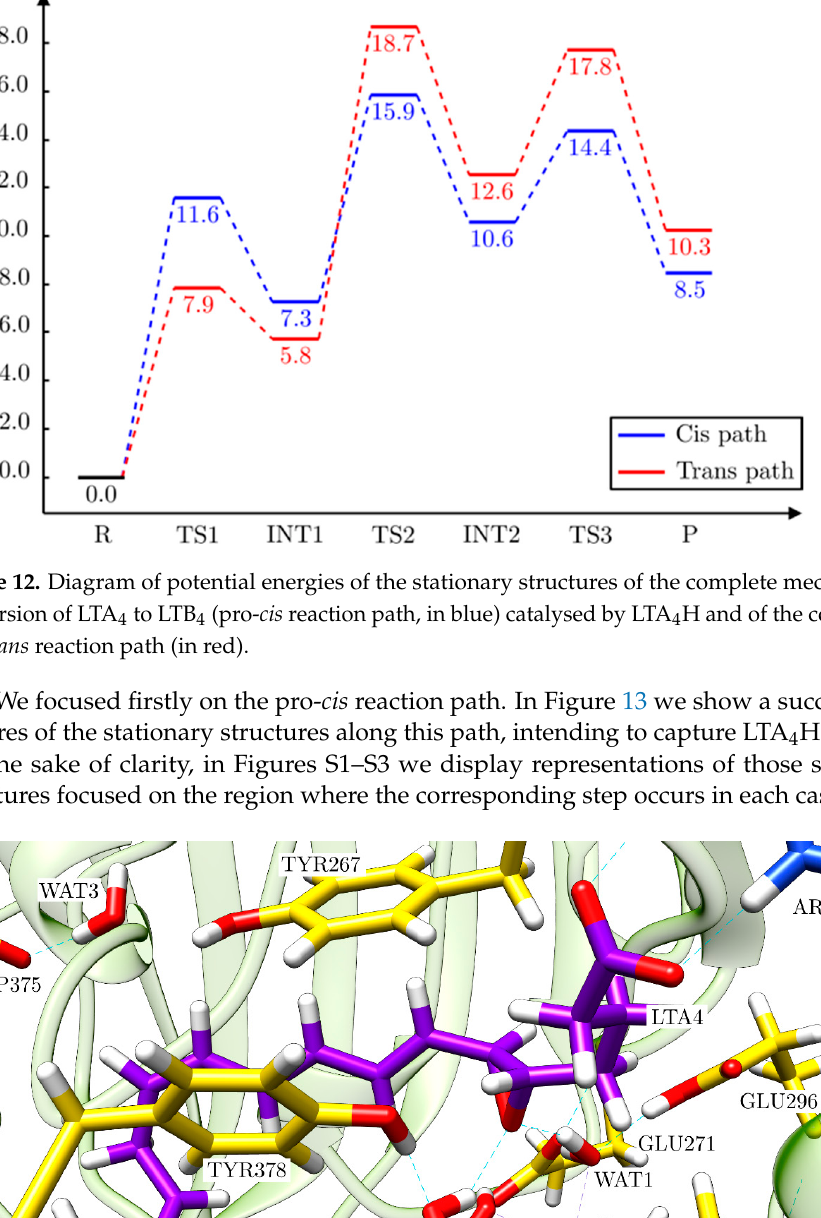
Figure 11. Position of WAT3 with respect to the plane generated by the triene moiety in the reactant LTA 4 (pro- cis , yellow disk), in INT1trans (pro- trans , brown disk) and in INT1cis (pro- cis , violet disk).